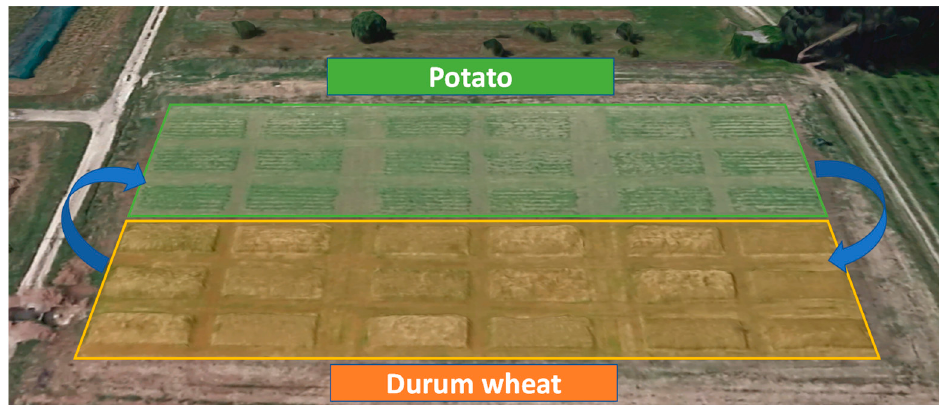
Figure 1. Experimental field plan of durum wheat–potato rotation.